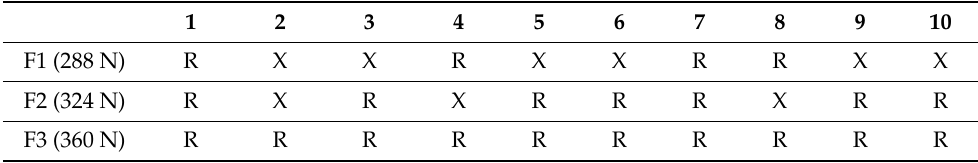
Table 3. Friction sensitivity test results for PBX 1